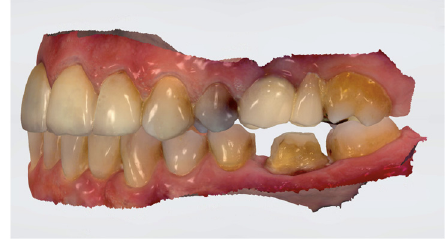
Figure 2. Digital impression.